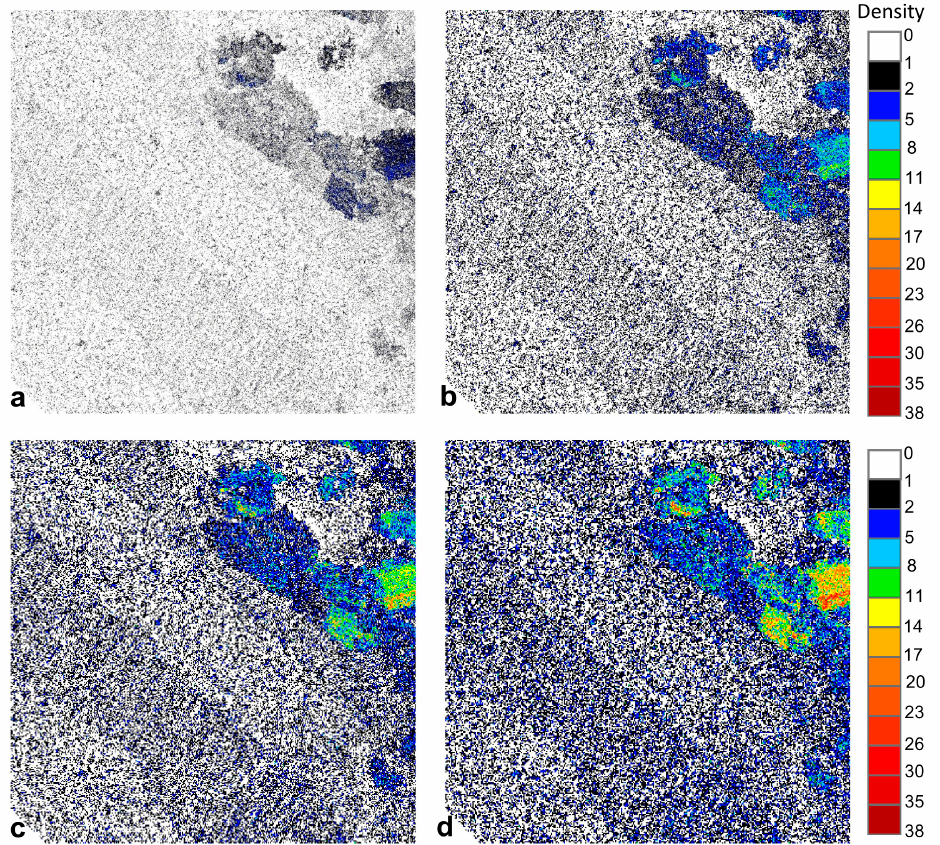
Figure 3. Illustration of the sensitivity of the airborne LiDAR ground returns density to grid cell size, showing the number of ground returns in ( a ) 1 m × 1 m grid cells (85% contain no ground return data), ( b ) 2 m × 2 m grid cells (60.4% contain no data), ( c ) 2.5 m × 2.5 m grid cell (49.3% contain no data), and ( d ) 3 m × 3 m grid cells (39.7% contain no data). Example results for a 1 km 2 portion of the NE study area LiDAR transect (Figure 1a).